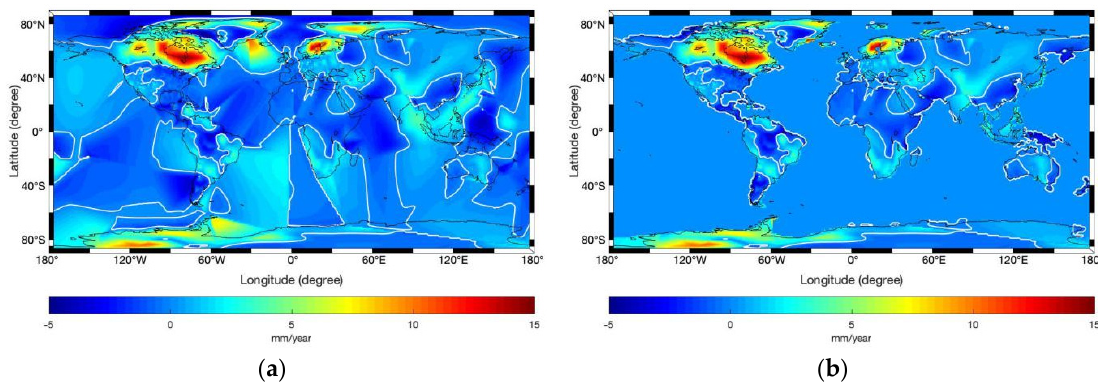
Figure 4. Preliminary processing of the GPS-derived GIA uplift rates as provided by Schumacher et al. [13]. ( a ) GIA uplift rates from fitted GPS solutions; ( b ) the same as (a) but with the landmask applied. The zero-motion contours are indicated by white curves.